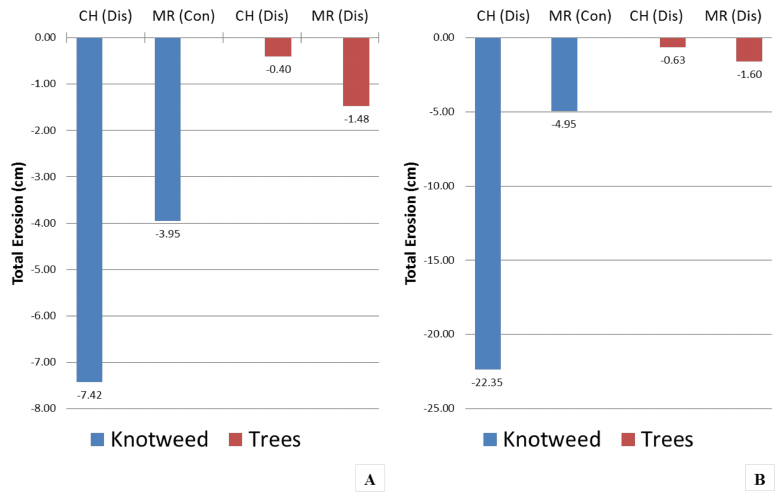
Figure 6. Total erosion at bank pin locations. The total erosion at each location from July to October 2015 ( A ) and October 2015 to March 2016 ( B ). The greatest amount of erosion occurred at the upstream highly disconnected reach containing mixed knotweed (CH BP Up) followed by a connected reach with knotweed (MR BP up). The least amount of erosion occurred at the downstream disconnected reach containing trees (CH BP Down) followed by a disconnected reach with trees (MR BP